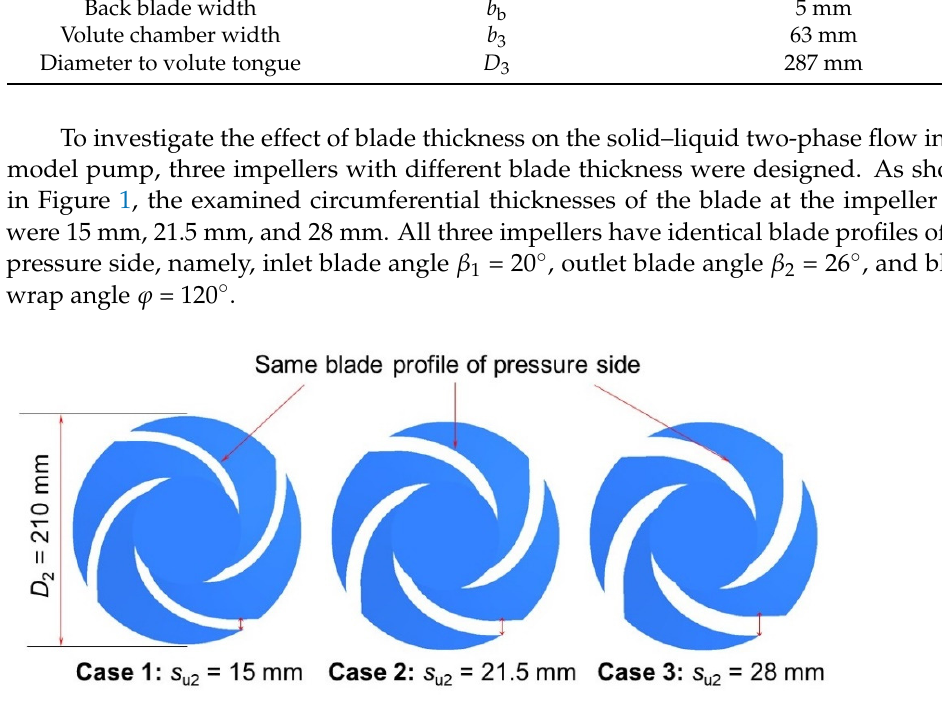
Figure 1. Geometric configuration of each examined case.